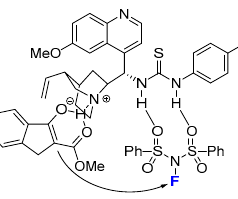
Figure 6. Structure of different organocatalysts.